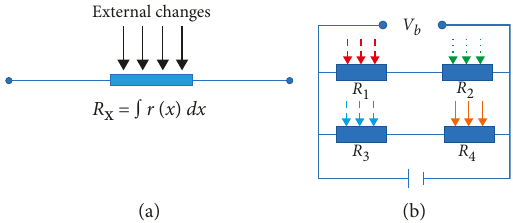
Figure 6: Electrical behavior of the carbon fiber (a) resistance layout due to straining. (b) Resistance layout due to wetting. (c) Wheatstone bridge ( R x designates the resistance of the carbon fiber and V b is the measured voltage) [52].